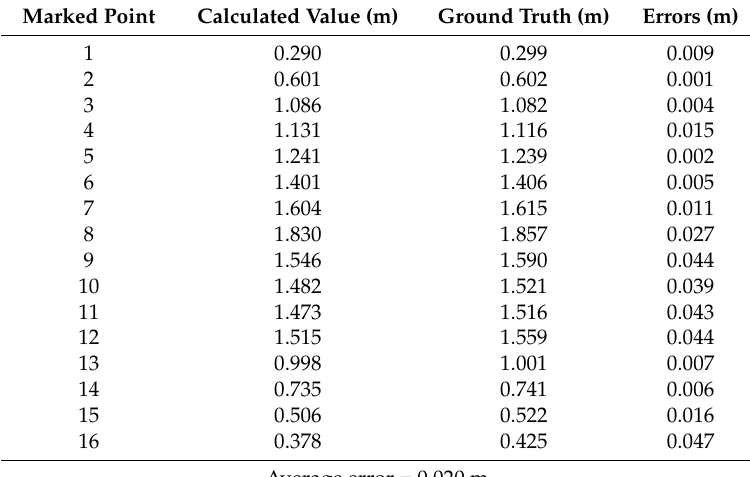
Table 1. The accuracy compared with ground truth.